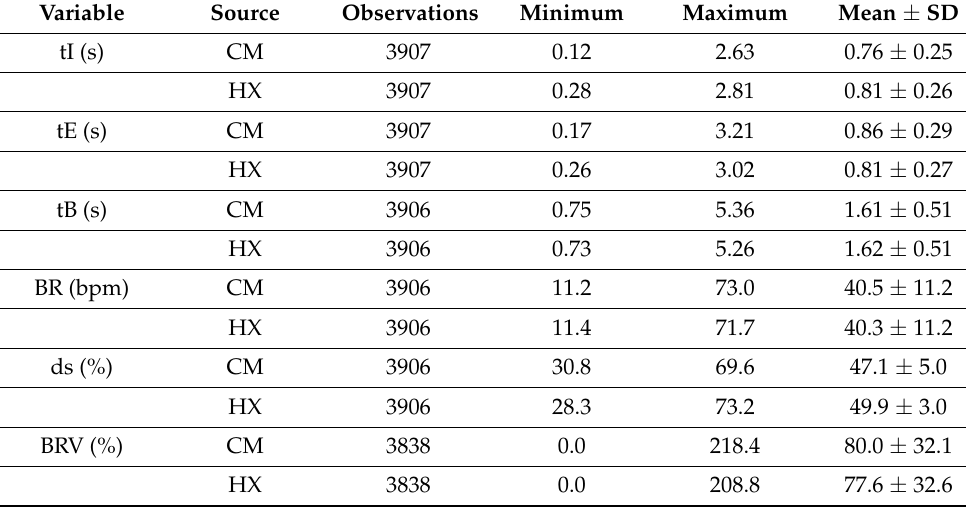
Table 2. Group sample